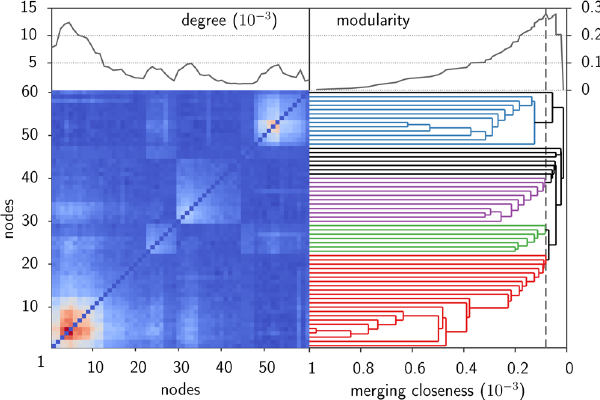
FIG. 1. Hierarchical community structure arising from a quan- tum evolution. On the left are the closenesses c ð i; j Þ between n ¼ 60 nodes. On the right is the dendrogram showing the resulting hierarchical community structure. The dashed line shows the optimum level within this hierarchy, according to the modularity. The particular example shown here is the one corresponding to Fig.